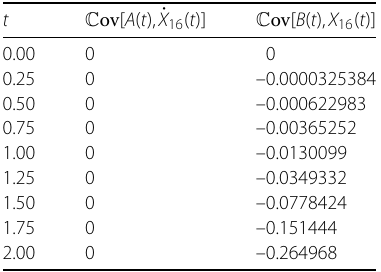
Table 3 Approximation of C ov [ A ( t ), ˙ X ( t )] and C ov [ B ( t ), X ( t )] via accurate truncations ˙ X 16 ( t ) and X 16 ( t ), respectively. Example 4.1, assuming independent random